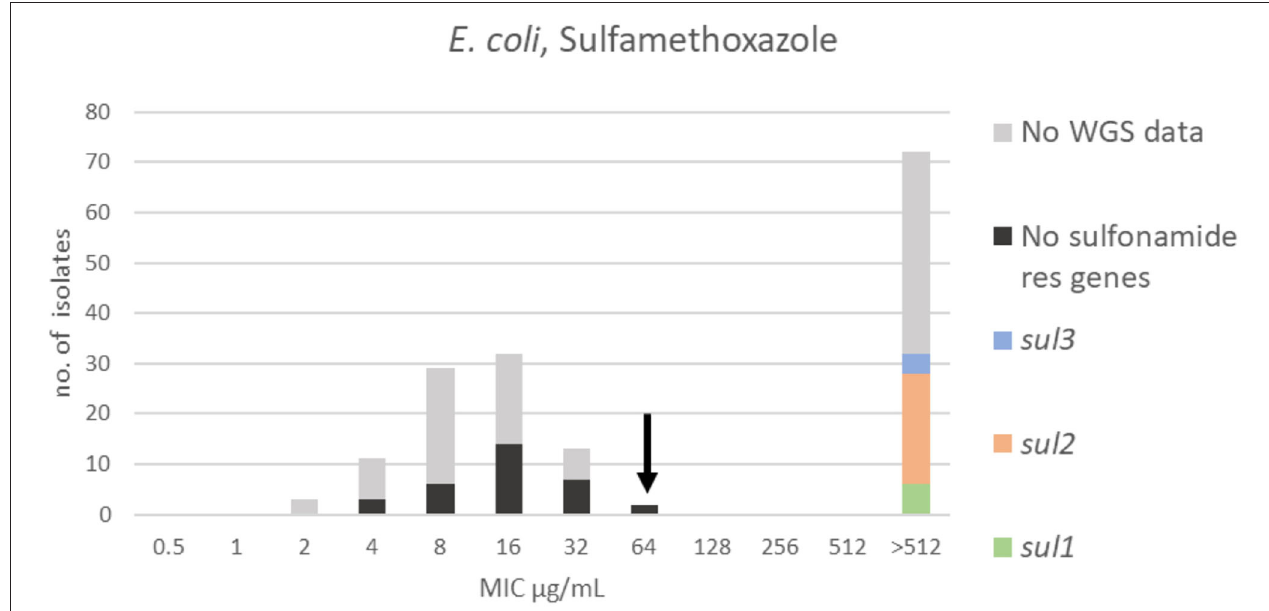
FIGURE 5 | MIC distribution of E. coli ( n = 162) against sulfamethoxazole in the test range of 0.5–512 µ g/mL. The arrow indicates the epidemiological cut-off value (ECOFF, EUCAST). Colors indicate if the isolates have been sequenced and whether they harbor known relevant resistance genes. WGS, whole-genome sequencing; res,